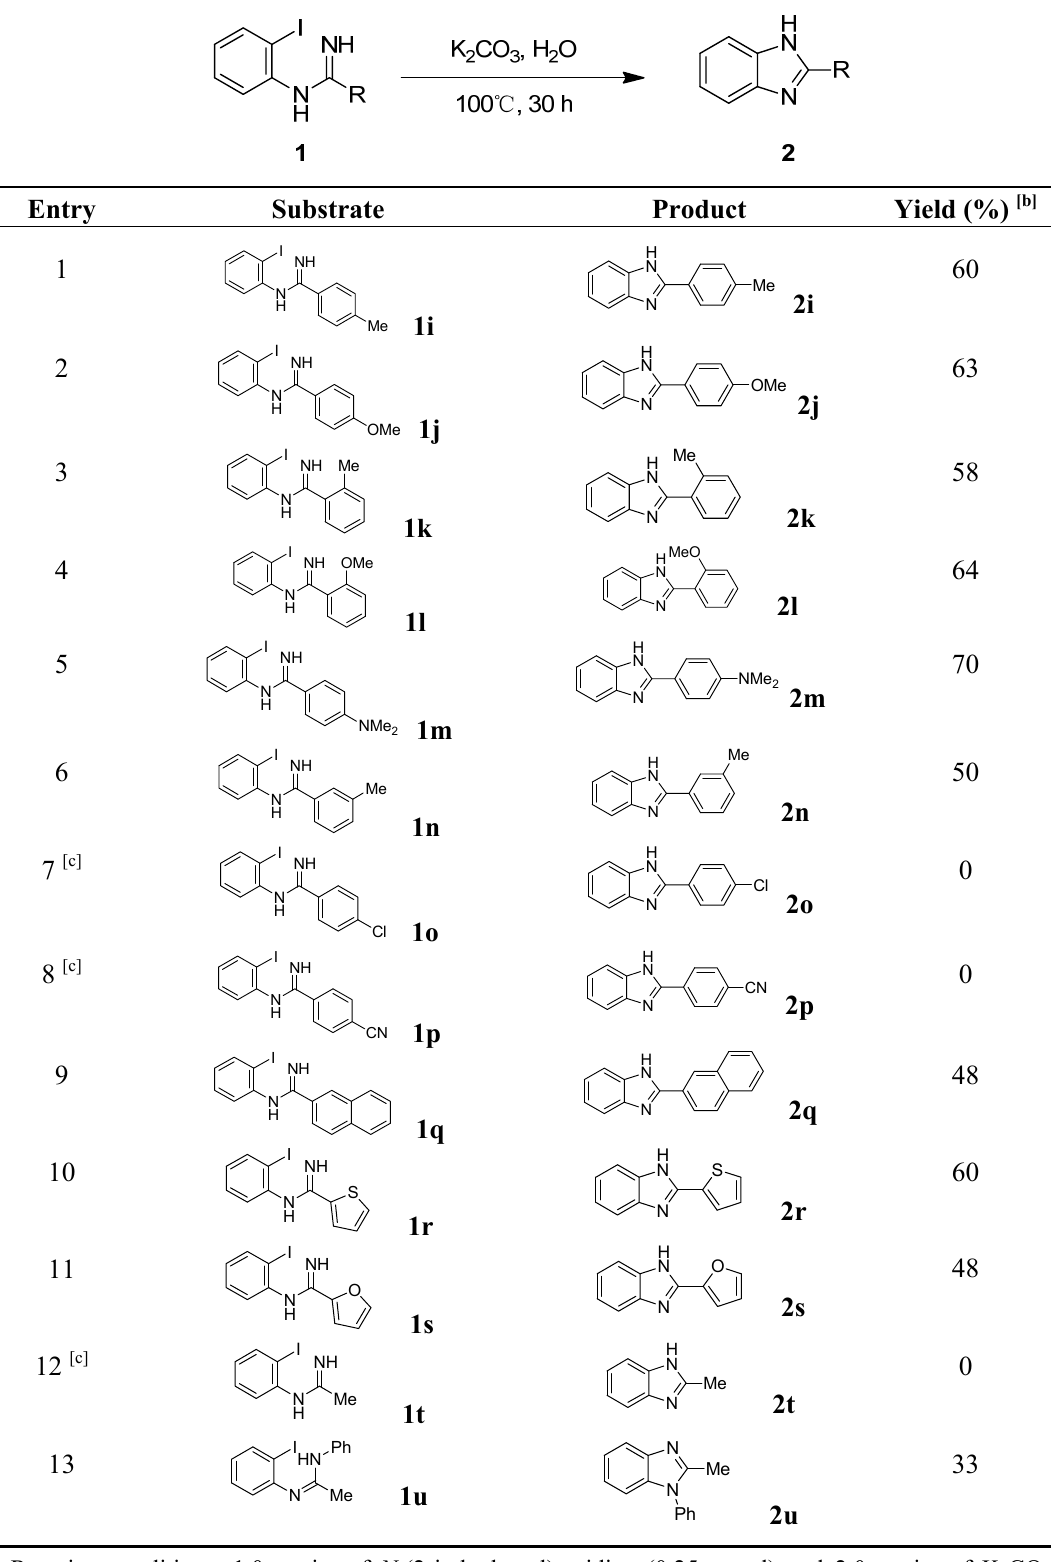
Table 3. Synthesis of 2-arylbenzimidazole derivatives in water [a]